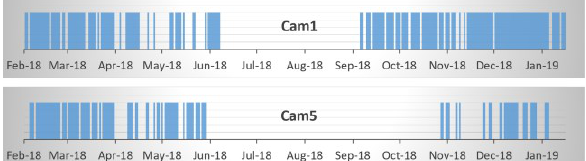
Figure 4: Overview on useful images of two cameras on the north and south ridge over one year of data acquisition